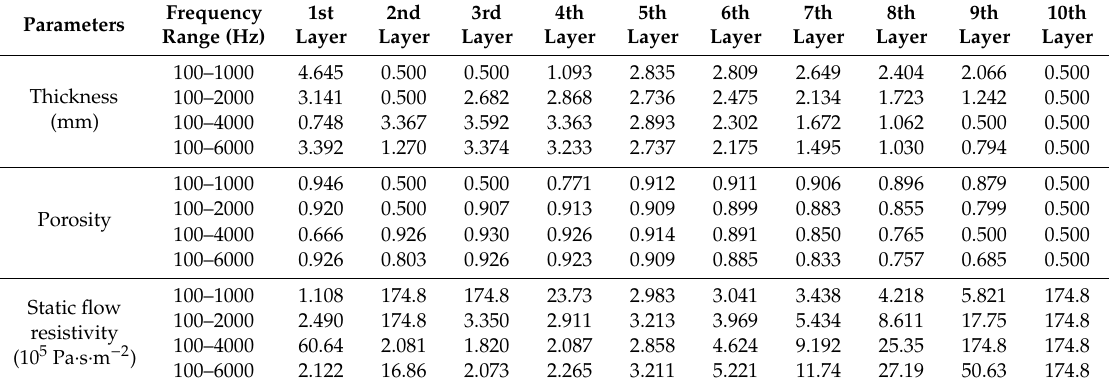
Table 3. Structural parameters of the optimal 10-layer gradient compressed porous